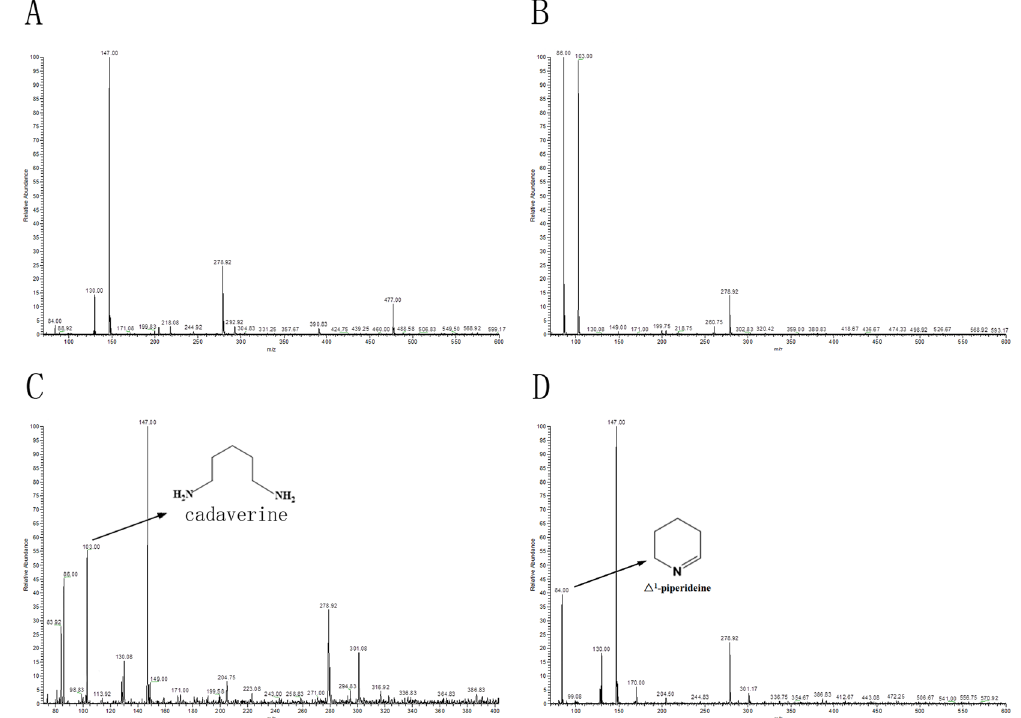
Figure 3. LC-MS analysis of products. ( A ) LC-MS analysis of L-lysine standard. ( B ) LC-MS analysis of cadaverine standard. ( C ) LC-MS analysis of enzymatic formation of cadaverine from L-lysine by CgLDC. Ion chromatograms extracted with m/z 103. ( D ) LC-MS analysis of enzymatic formation of Δ 1 -piperideine from cadaverine by CgCAO. Ion chromatograms extracted with m/z 84.